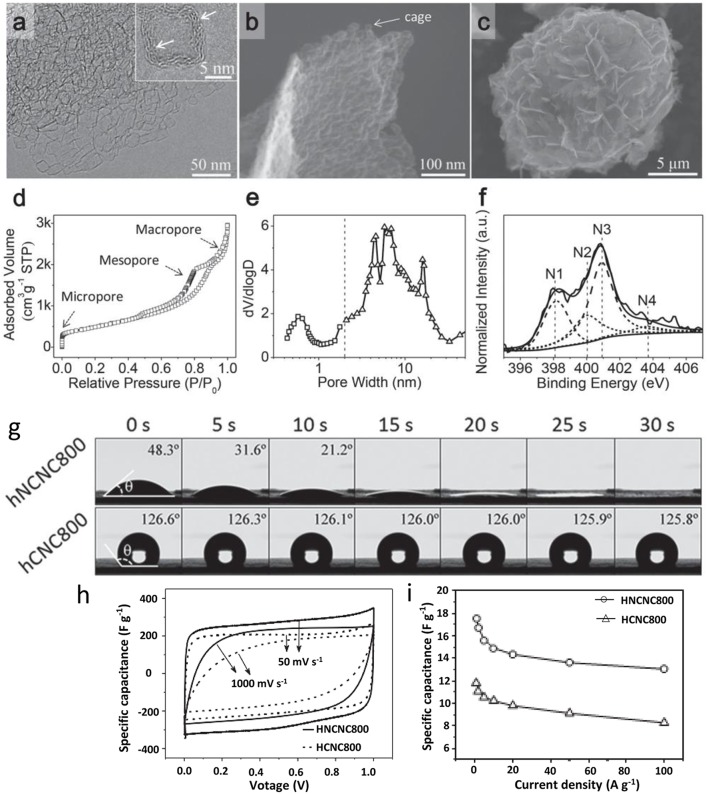
(a–c) TEM and SEM images of N-doped PC; (d-f) N2 adsorption/desorption isothermal, pore size distribution and XPS spectra of the sample; (g) wettability tests; (h,i) electrochemical performance analysis. Reprinted with permission from Zhao et al. (2015). Copyright 2015 Willey VCH.